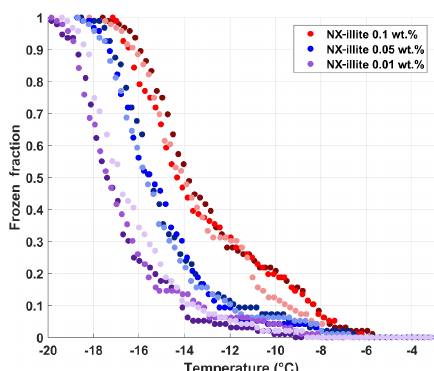
Figure A4. Frozen fraction curves of suspensions of 0.1wt% (red dots), 0.05wt% (red dots) and 0.01wt% (purple dots) of NX-illite run in triplicates as shown by